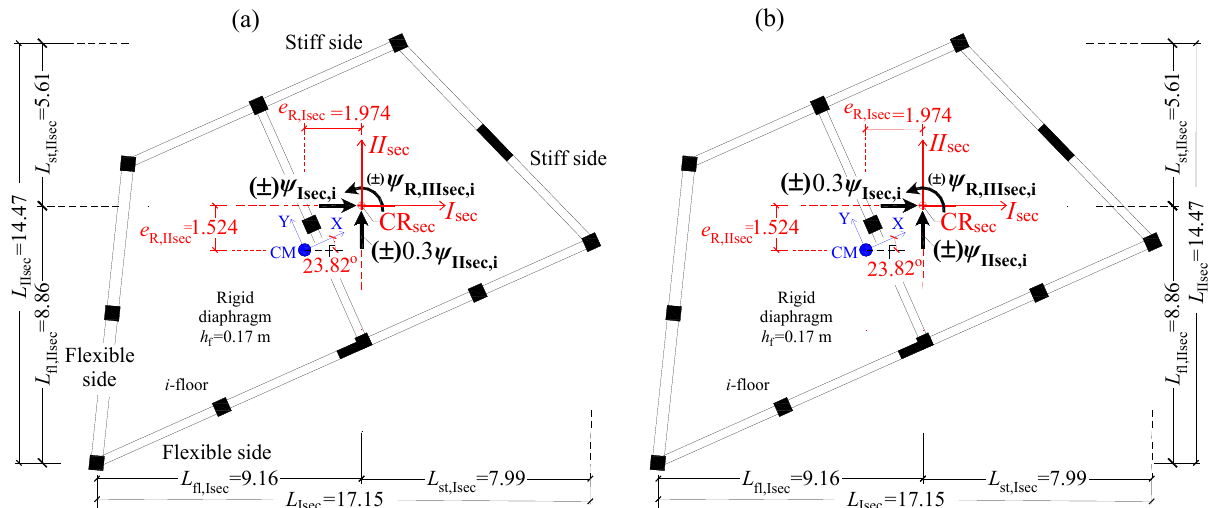
Figure 10. Earthquake spatial action of concurrently acting floor enforced-displacements in the framework of 16 pushover analyses: ( a ) 8 combinations ψ Isec,i ± 0.3 ψ IIsec,i ± ψ R,IIIsec,i , to maximize the displacement along I sec axis, ( b ) 8 combinations 0.3 ψ Isec,i ± ψ IIsec,i ± ψ R,IIIsec,i , to maximize the displacement along II sec